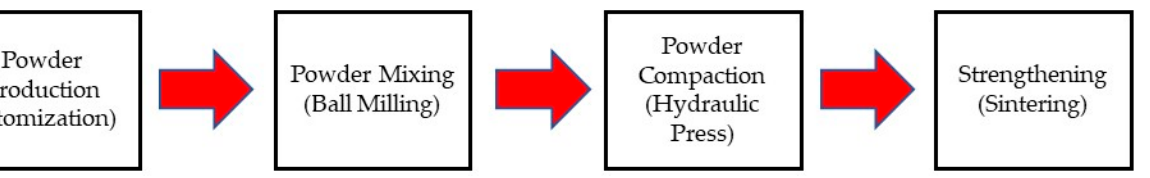
Figure 3. Processing route of powder metallurgy.